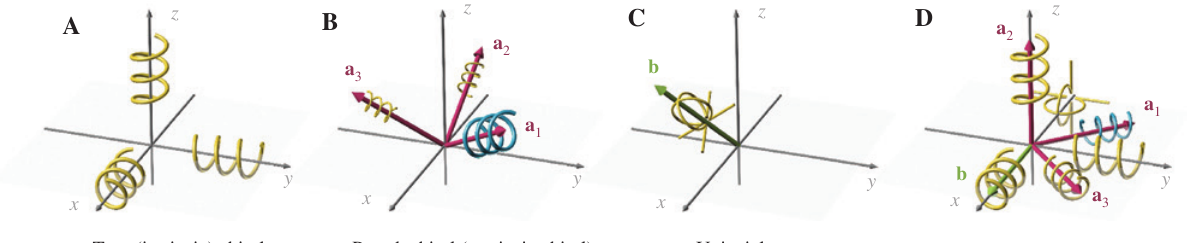
Figure 3: Conceptual realizations of basic reciprocal bianisotropic meta-atoms. (A) True (or intrinsic) chiral meta-atom. (B) Pseudochiral (extrinsic) meta-atom. The right- and left-handed helices are shown in yellow and blue, respectively. Different size of the helices corresponds to the different amplitudes of polarizabilities. (C) Uniaxial omega meta-atom. (D) The conceptual representation of the bianisotropic meta-atom with electromagnetic coupling described by